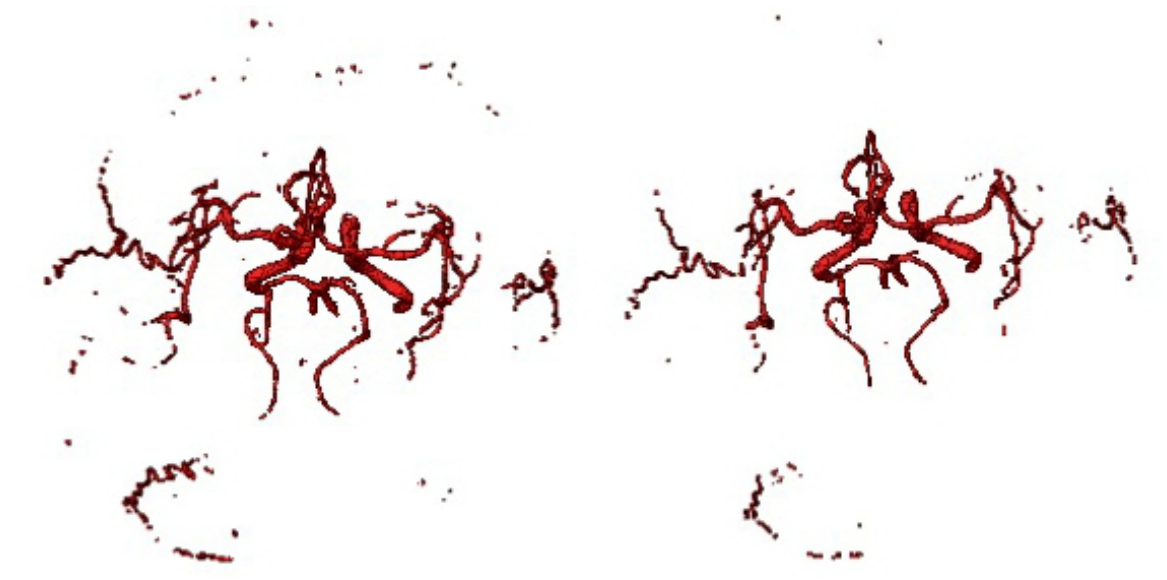
Figure 7. Comparison of G - MRF and double Gaussian model segmentation result. Left: G - MRF segmentation result; right: double Gaussian model segmentation result.